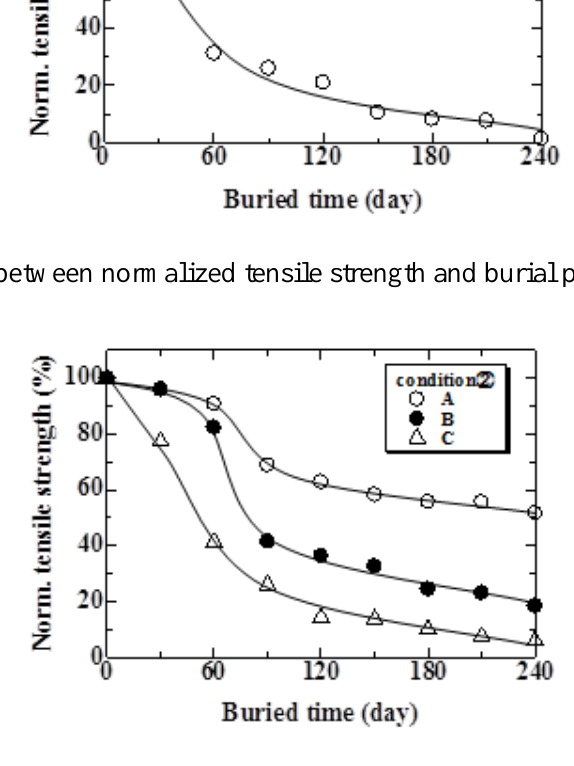
Figure 8. Relationship between normalized tensile strength and composting time under Condition 3 and